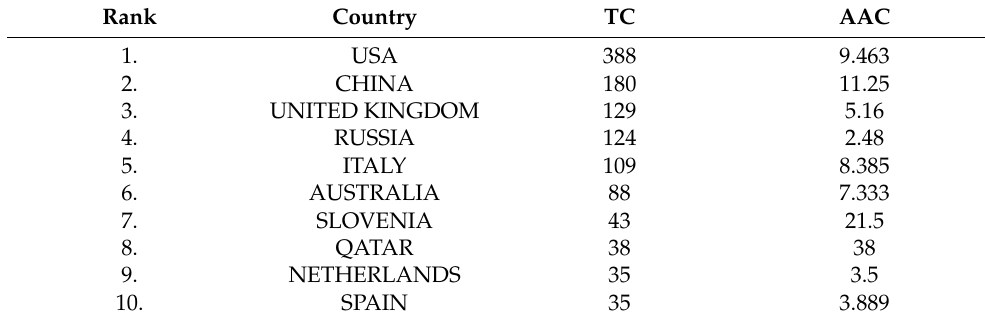
Table 10. Top 10 most cited countries (2015–2019). Total Citations (TC) and Average Article Citations (AAC).